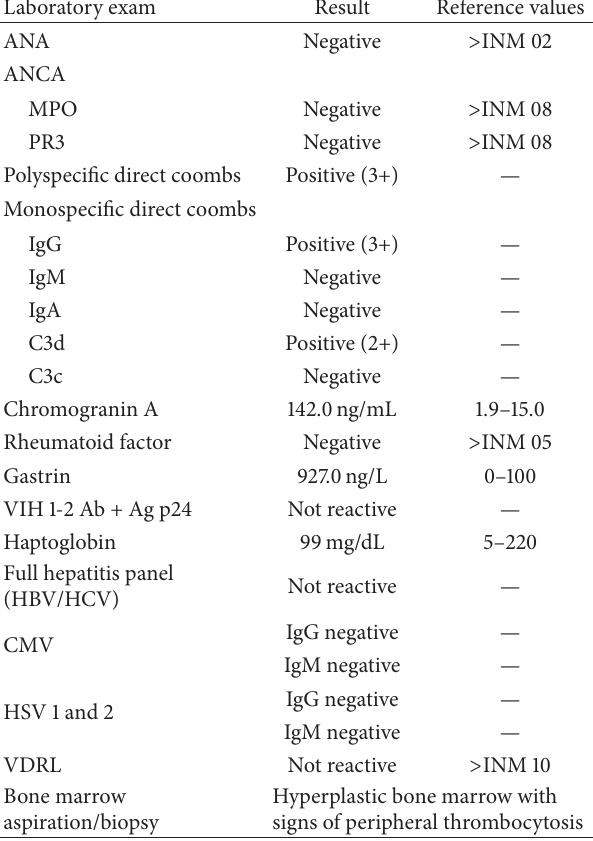
Table 1: Test results for initial and differential diagnoses.